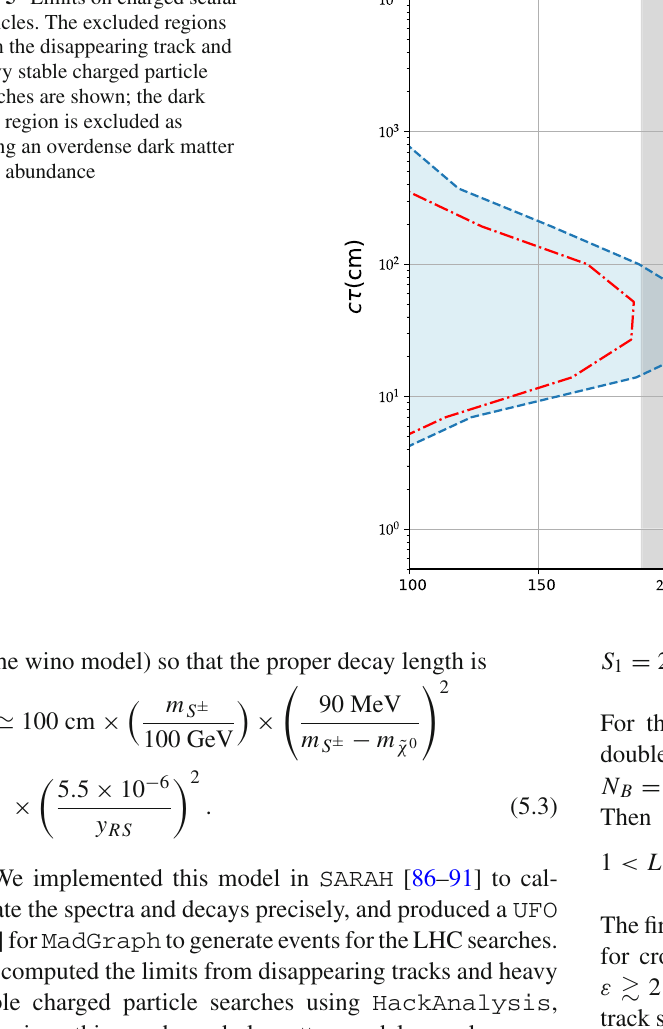
Fig. 5 Limits on charged scalar particles. The excluded regions from the disappearing track and heavy stable charged particle searches are shown; the dark grey region is excluded as giving an overdense dark matter relic